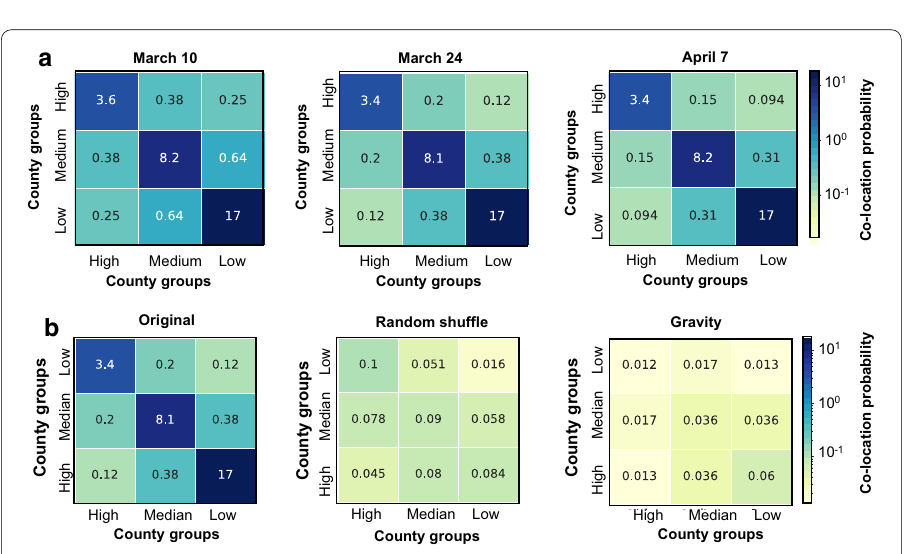
Fig. 6 (a) Co-location probability across different county groups for three different time periods. (b) The results generated were based on original data (24 March 2020), random shuffle, and gravity model with input of population size for testing the significance of the segregation of co-location patterns based on travel across different county groups. The value in each cell is the sum of the co-location probabilities of the same type of edges. High, medium, and low groups are the groups of counties which are ranked by the number of confirmed cases on 31 March 2020 (the ranks based on the data in different weeks were performed as a sensitivity test provided in Additional file 1). The sizes of the groups are equal (about 1,000 counties per group). The color bar is consistent for the heat maps in the same